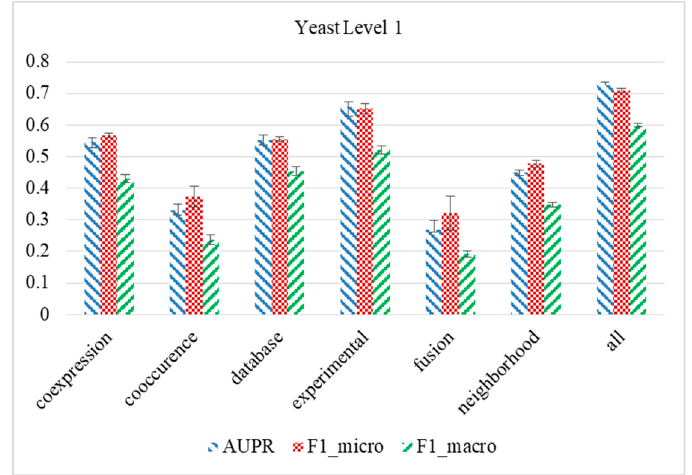
Figure 2. Comparison of predictive performance of multiple network integration with performance of single network.